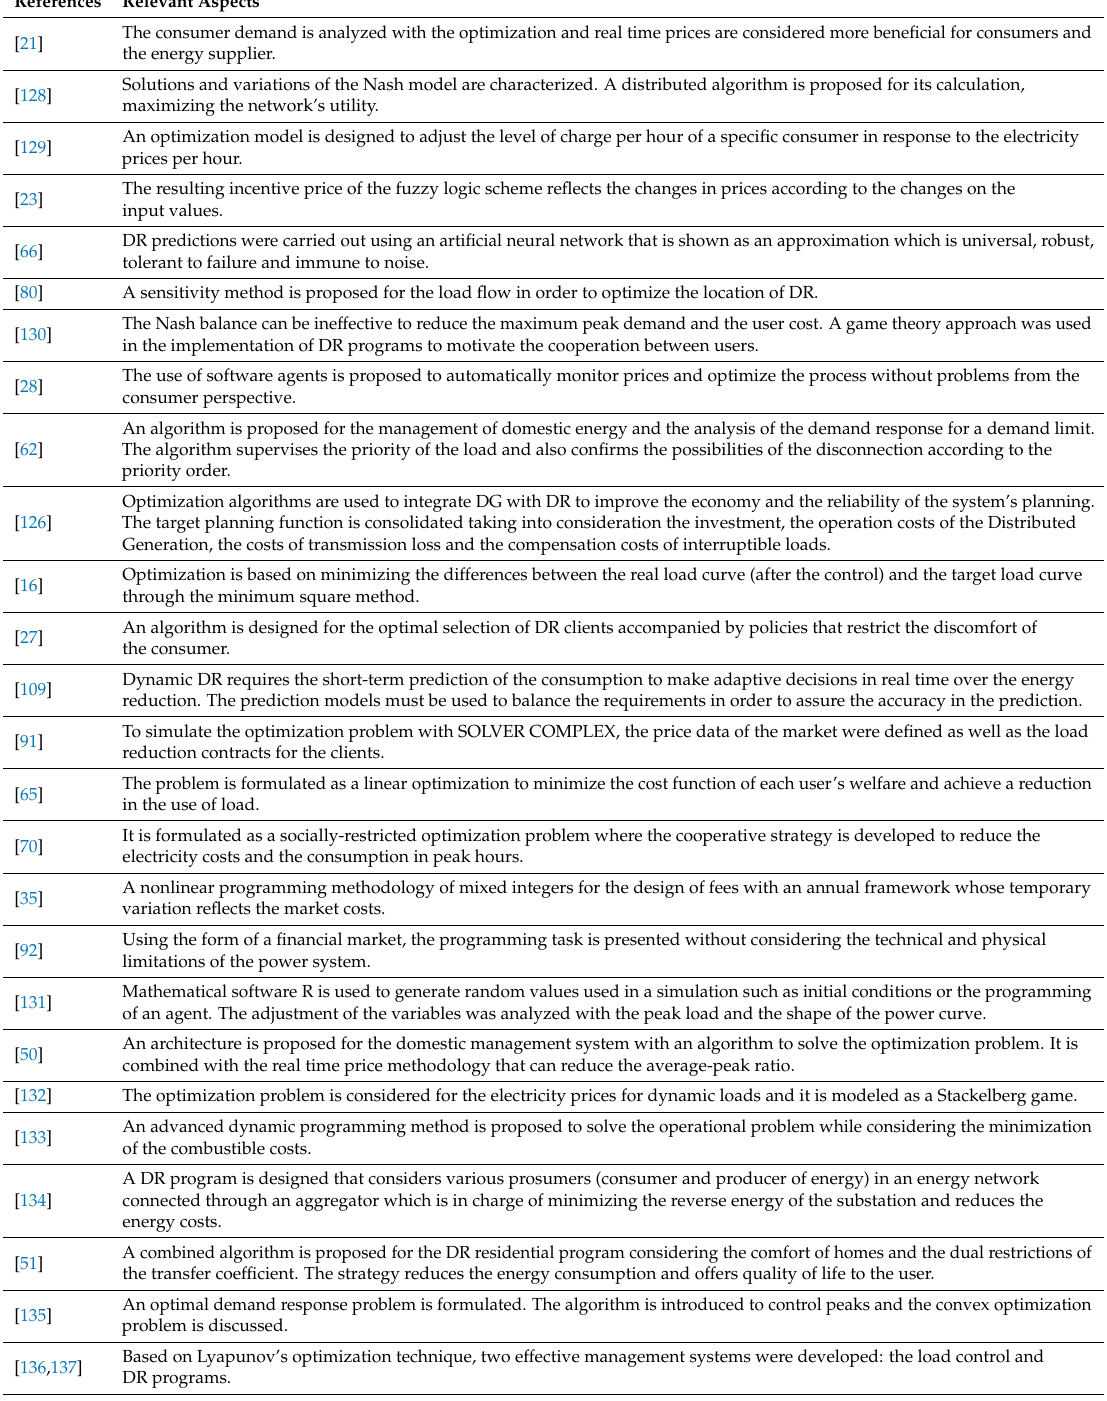
Table 7. DR from the optimization